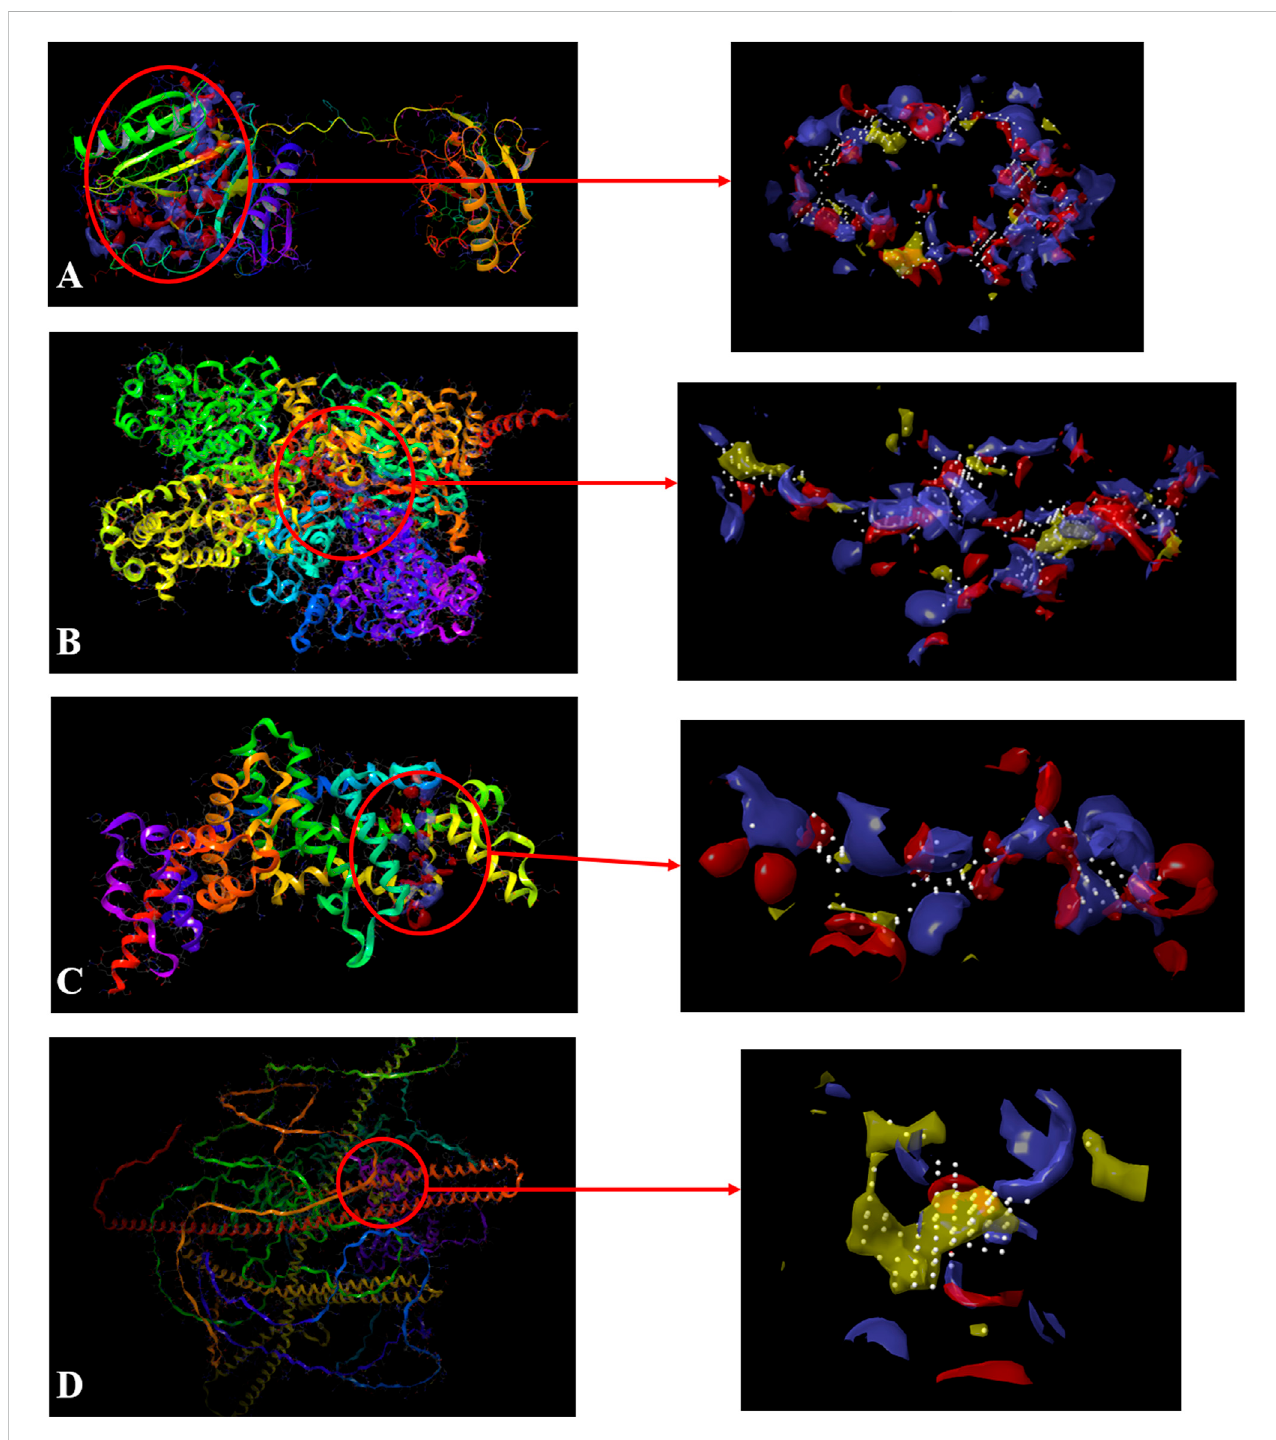
FIGURE 3 Sitemap-predicted site of Macrophage-capping protein (PDB ID: 1J72) (A) , UDP glucose: glycoprotein glucosyltransferase 2 (Gene: UGGT2) (AlphaFold) (B) , Ras GTPase-activating-like protein (PDB ID: 3FAY) (C) , RIMS-binding protein 3A (Gene: RIMBP3) (AlphaFold) (D) . (Yellow: Hydrophobic area, Blue: Hydrogen bond donor, Red: Hydrogen bond acceptor, White spheres: Site